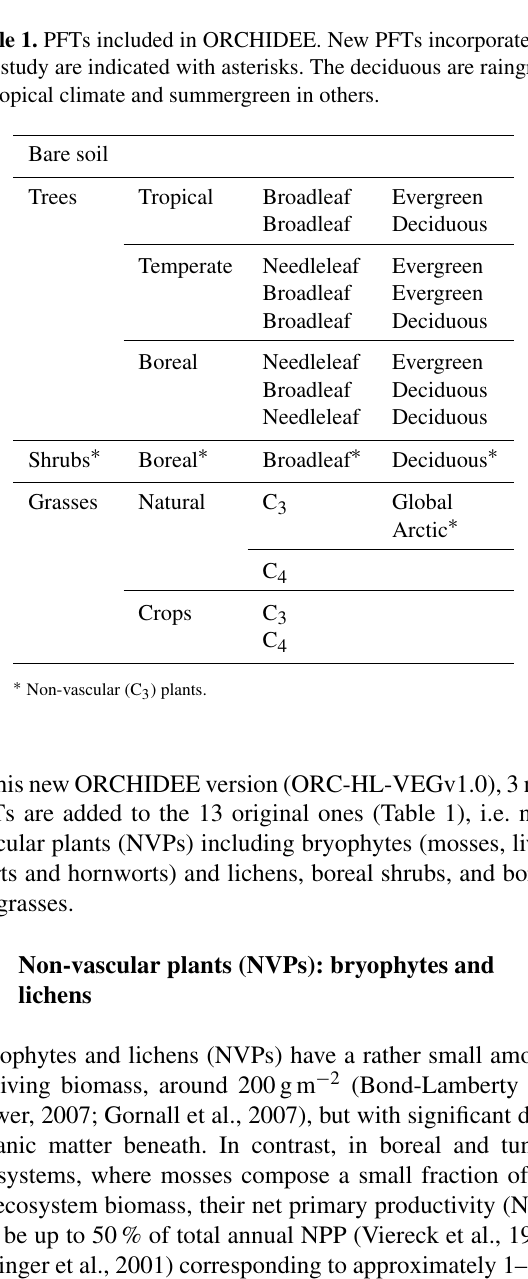
Table 1. PFTs included in ORCHIDEE. New PFTs incorporated in this study are indicated with asterisks. The deciduous are raingreen in tropical climate and summergreen in others. Bare soil Trees